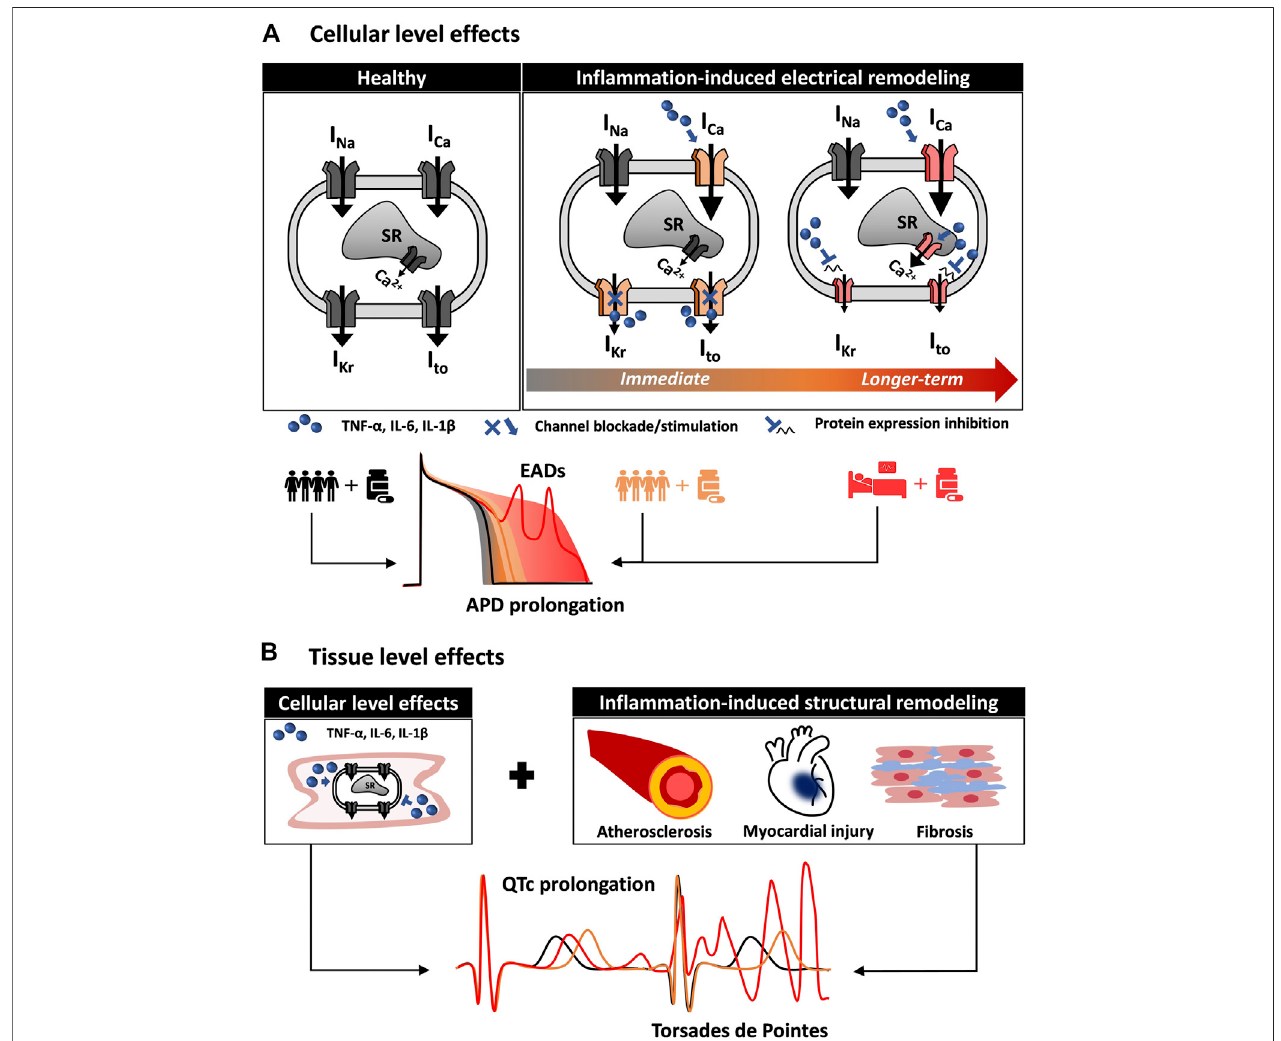
FIGURE1| Multiscalequantitativesystemspharmacology tointegratein fl ammationmodelinginto insilico drugsafetyevaluation. (A) In fl ammationinducescardiac electrical remodeling. Proin fl ammatory cytokines can alter cardiac electrophysiology by interacting directly with the cardiac ion channels. By altering the normal function (immediate effect) and expression of cardiac ion channels (longer-term effect), in fl ammation is a source of variability in the cardiomyocyte response to the administration of drugs. In addition to variability among healthy individuals (black line and gray shaded area), the in fl ammatory state (orange and red) can profoundly alter the cellular pro-arrhythmia risk metrics normally evaluated in in silico drug safety. (B) In fl ammation affects cardiac tissue pro-arrhythmia risk metrics. In fl ammation also contributes to cardiac structural remodeling, affecting cardiac propagation and creating a proarrhythmic substrate. Together with the effects on the single cardiomyocyte, this can result in altered (orange and red) QT interval on the ECG.